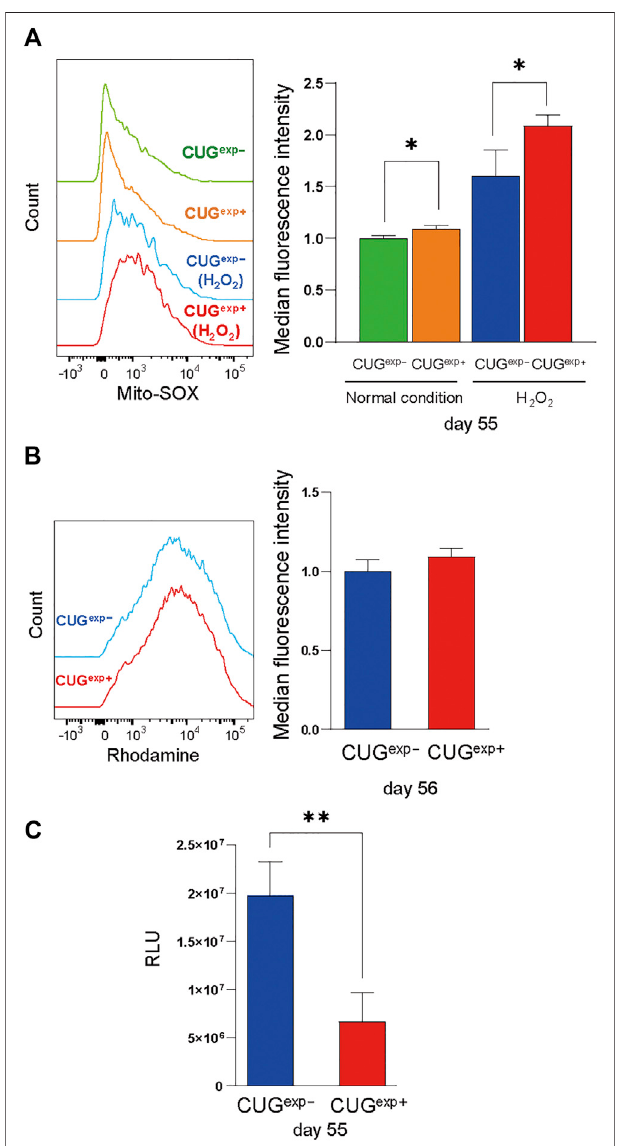
FIGURE 5 | Expanded CUG repeat RNA impairs mitochondrial function and increases ROS. (A) Left: Flow cytometry histograms of mitochondrial ROS in cells not expressing CUG exp (CUG exp − ) (green) and cells expressing CUG exp (CUG exp+ ) (orange) at day 55 under normal conditions and following H 2 O 2 exposure (CUG exp − , blue, and CUG exp+ , red). Right: Bar graph showing MFI values for mitochondrial ROS. Data are presented as means ± SD of three independent experiments. * p < 0.05. (B) Left: Flow cytometry histograms of Rhodamine 123 in CUG exp − (blue) and CUG exp+ cells at day 56 (red). Right: Bar graph showing MFI values for Rhodamine 123. Data are presented as means ± SD of three independent experiments. (C) Quanti fi cationofintracellular ATPproduction by fi re fl yluciferaseluminescence at day 55. Data are presented as means ± SD of three independent experiments. ** p < 0.01. RLU: relative light units.